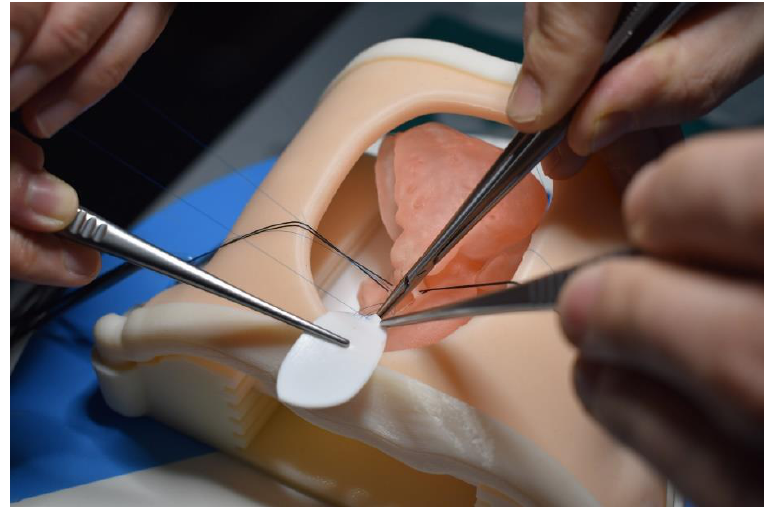
Figure 13. Example of simulation of Tetralogy of Fallot repair on a 3D-printed heart model. Reprinted with permission under the open access from Hon et al. [89].